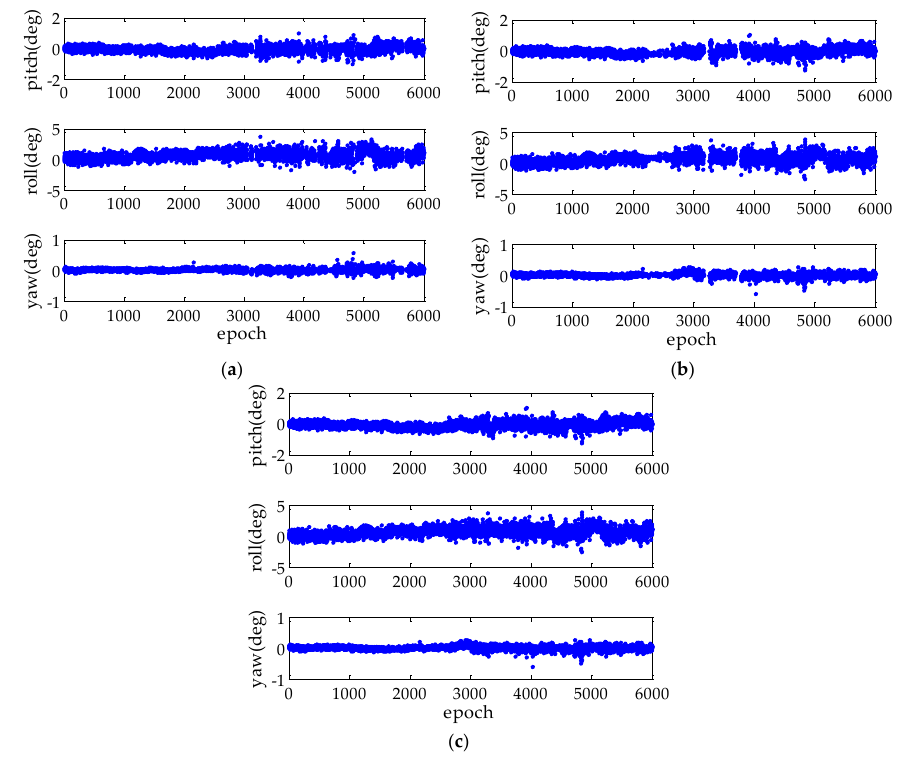
Figure 8. Attitude error for three AD methods in kinematic experiment: ( a ) is the FAR-PAD method; ( b ) is the FAR-MAD method; and ( c ) is the PAR-MAD method.